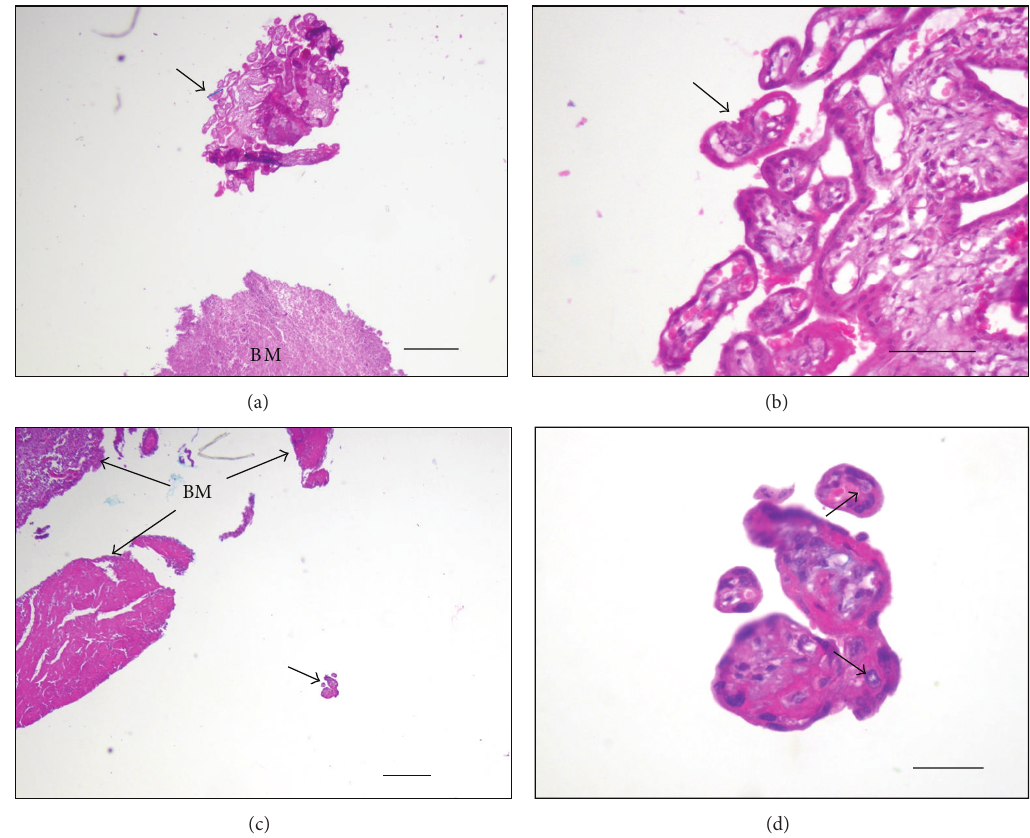
Figure 5: Chorionic villous-like structures observed in the vicinity of the bigger mass. (a) The bigger mass (BM) was found in relation to a number of chorionic villi (arrow) that at higher magnification resemble the human placenta. (b) High magnification of the chorionic villi showed in (a). These villi display a human placental appearance rather than degus. In fact, each villus has a central core of loose connective tissuesurrounded by a double layer of trophoblast,an outer syncytiotrophoblast and an inner cytotrophoblast. Fetal placental capillaries in the central core are clearly observed. (c) Spatial relation of the bigger mass (BM) with another group of chorionic villi (CV) with the same human placental appearance as shown in (a and b). (d) Higher magnification of the chorionic villi (arrow) observed in (c) showing the presence of two inner cytotrophoblasts (arrows). H/E staining. Calibration bars: (a) = 245 𝜇 m; (b) = 1225 𝜇 m; (c) = 245 𝜇 m; (d) = 600 𝜇